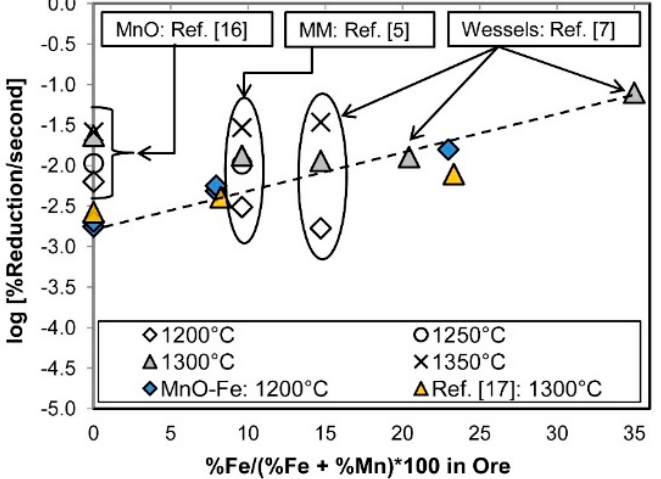
Figure 2. ( a ): %MnO reduction vs. temperature (°C); ( b ) %MnO reduction vs. mass% Fe added.